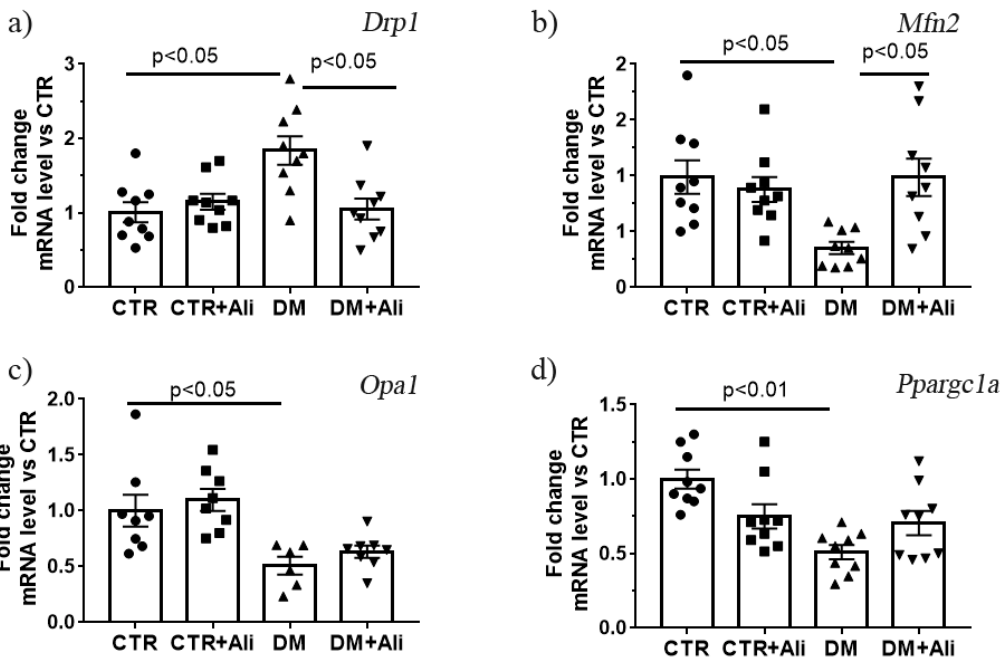
Figure 8. The relative mRNA levels of Drp1 ( a ), Mfn2 ( b ), Opa1 ( c ), and Ppargc1a ( d ) in the skeletal muscle of experimental animals. The values are given as mean ± SEM ( n = 6–9).